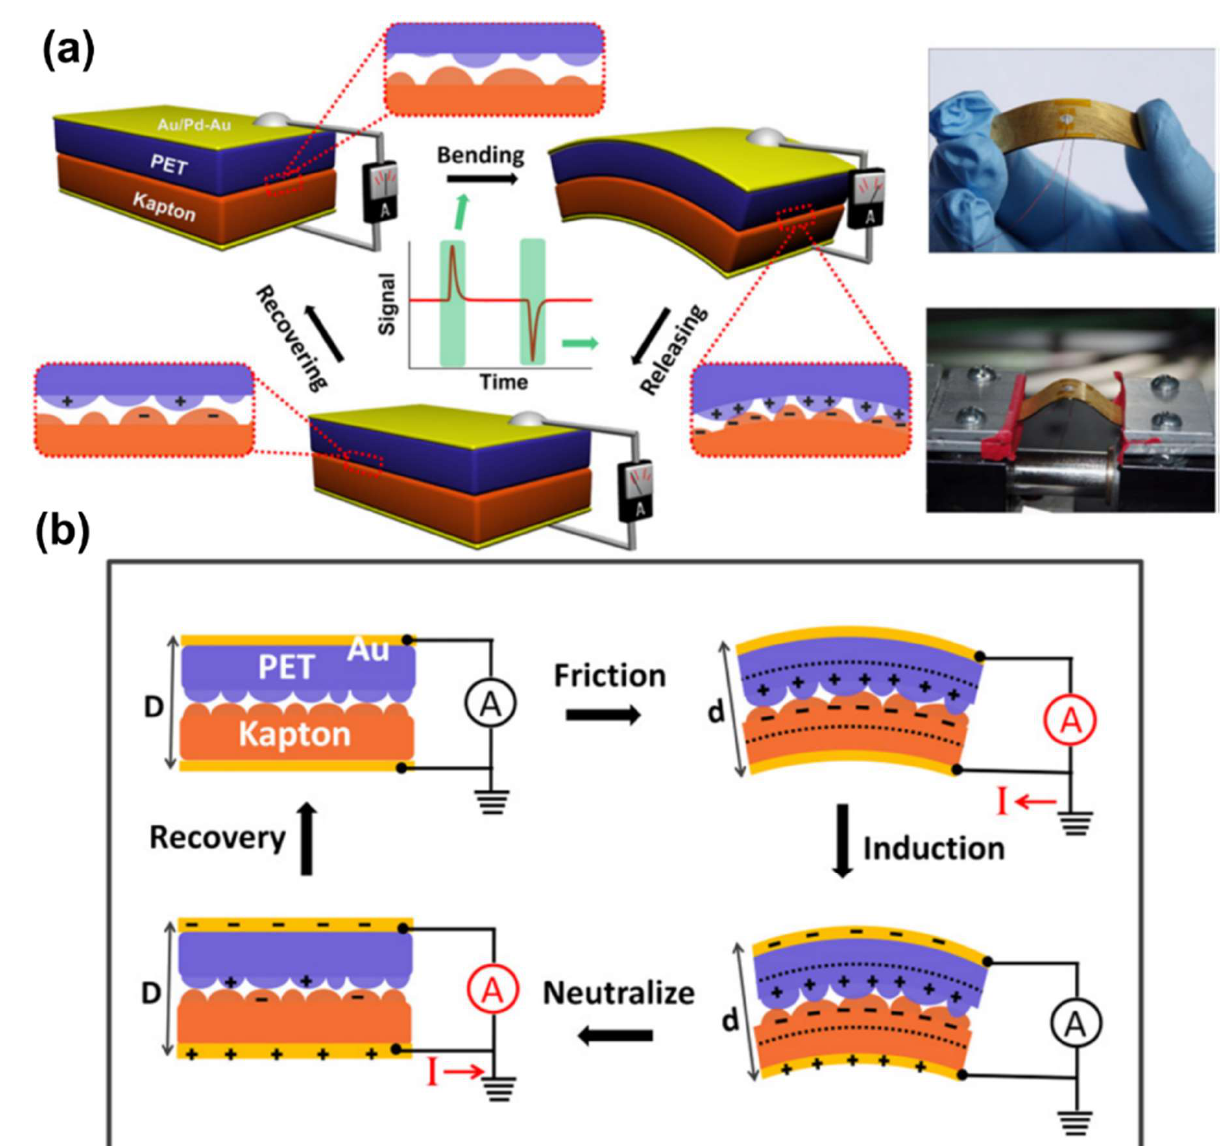
Figure 11. Schematic illustrations of a triboelectric generator. ( a ) Structure of an integrated generator while bending and releasing and related electrical tests. Photographs of a flexible TEG and mechanical bending equipment. ( b ) Proposed mechanism of a TEG: charges are generated by frictioning two polymer films, creating a triboelectric potential layer at the interface (dashed lines); mechanical compression alters the distance between the two electrodes (D to d); thus, driven by Table 235. Copyright © 2021 Elsevier Ltd. All rights reserved.